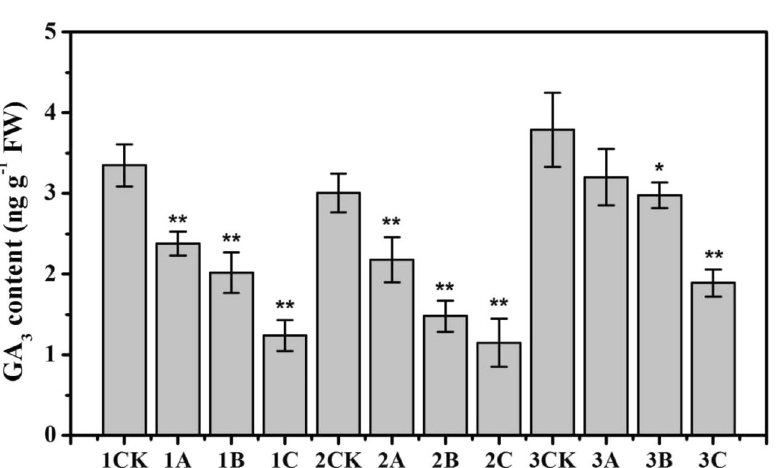
Figure 3. ( a ) Soluble protein content, ( b ) sucrose content, ( c ) glucose content, and ( d ) fructose content in rice seeds after being subjected to different doses of N ion beam irradiation. The means (± SEs) were calculated from three replicates per treatment. * and ** denote significances at the P < 0.05 and P < 0.01 levels, respectively, compared with the control group.